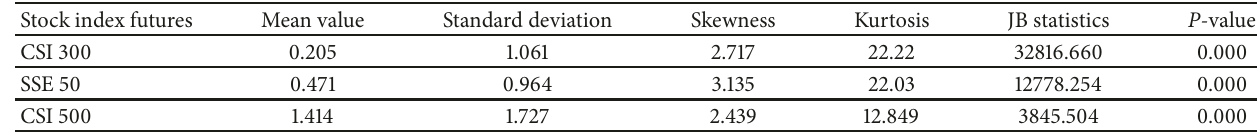
Table 2: The descriptive statistics of basis sequences for stock index futures.